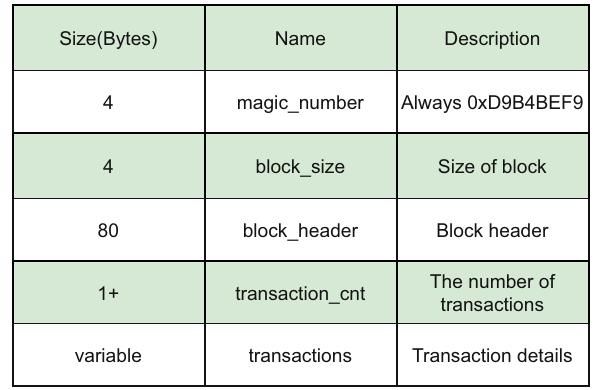
Fig. 4 Block structure of